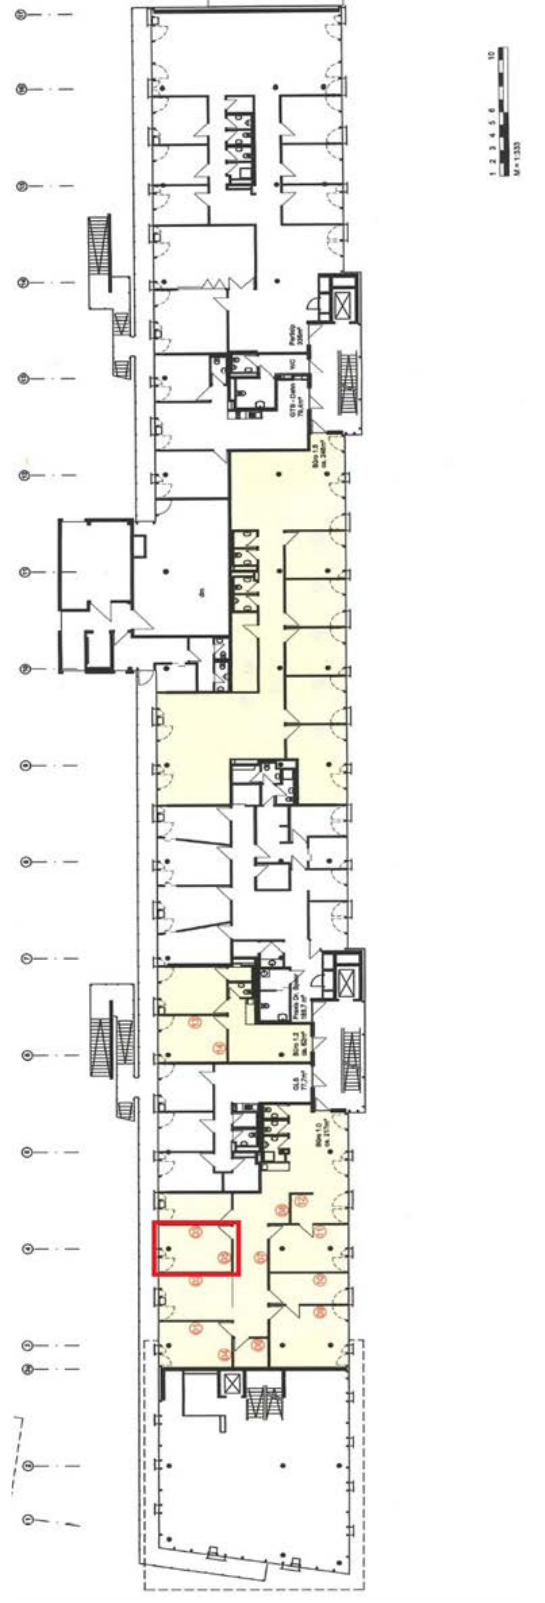
Figure A2. Drawing of the office floor in the Sonnenschiff. Red numbers in the red circles designate the partitions equipped with PCM plasterboard. The red box indicates the analysed room [17].